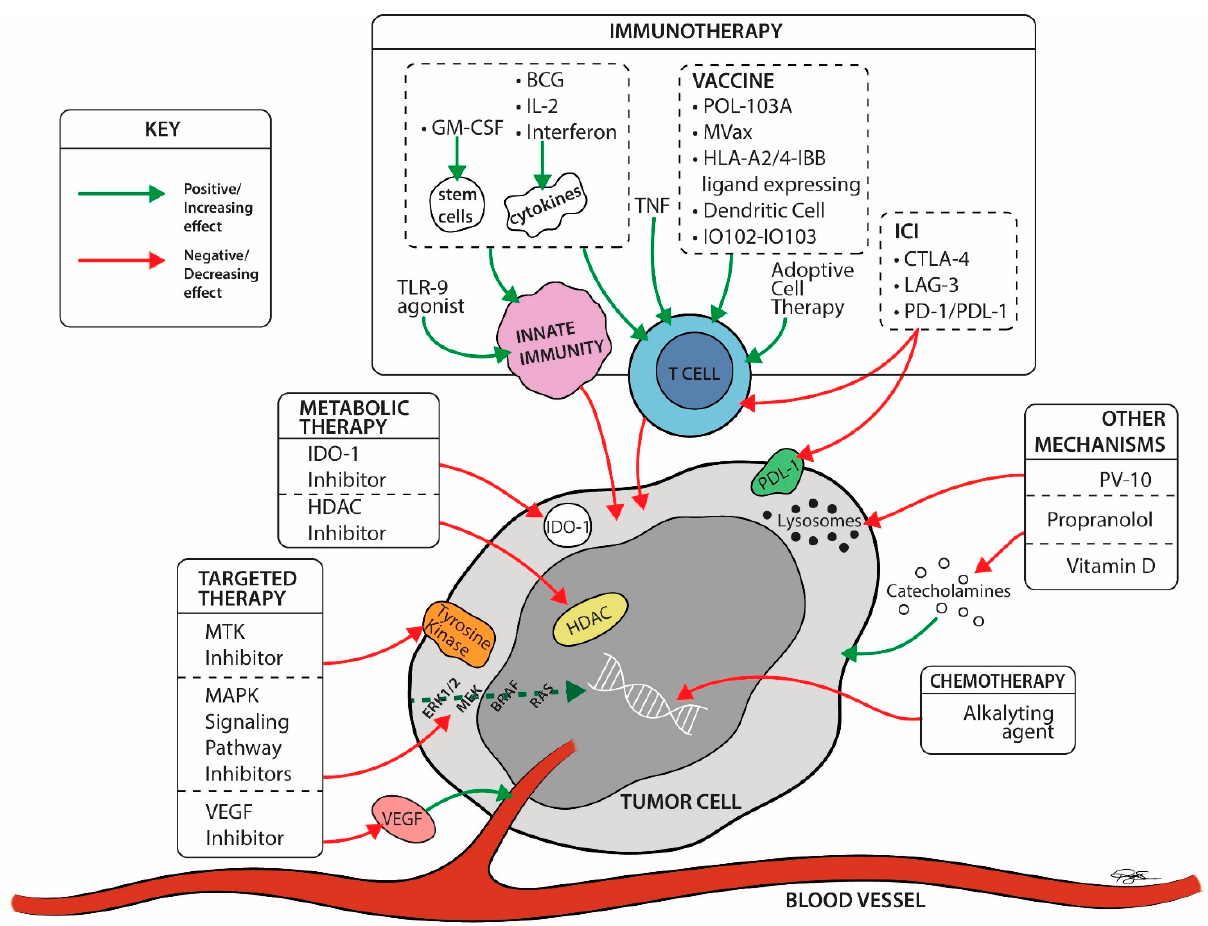
Figure 4. Late-stage trial drug mechanisms by site of action ©2022 University Hospitals Health System Inc. IO102 = a peptide vaccine derived from the enzyme IDO, and the montanide ISA-51. IO103 = a peptide vaccine derived from the tumor associate antigen (TAA) programmed cell death-1 ligand 1 (PD-L1). BCG = Bacillus Calmette-Guerin; CTLA-4 Ab = cytotoxic T lymphocyte associated protein-4 antibodies; ERK = extracellular signal-regulated kinase; GM-CSF = granulocyte monocyte colony stimulating factor; HDAC = histone deacetylase; IDO-1 = indoleamine 2, 3-dioxygenase 1; IL2 = Interleukin 2; LAG-3 = Lymphocyte Activation Gene-3; MAPK = mitogen-activated protein